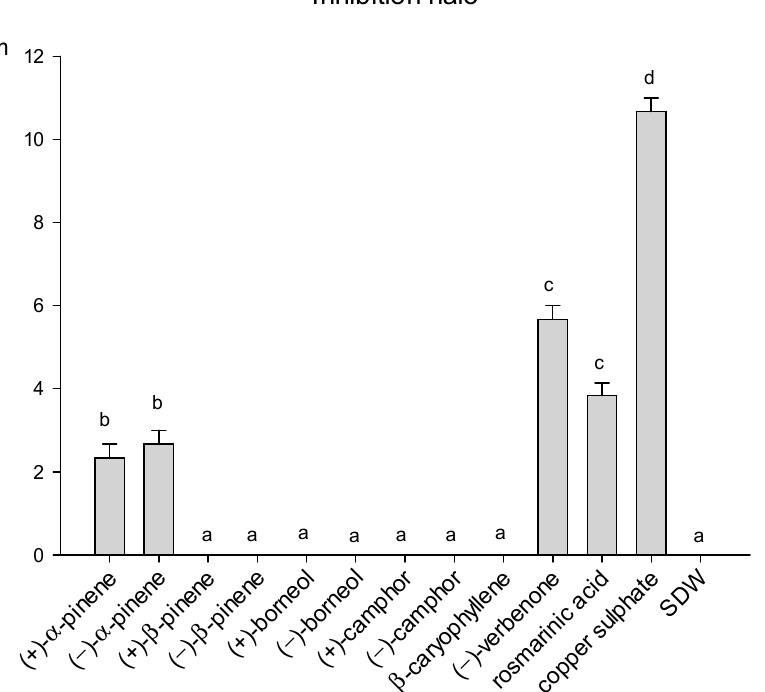
Figure 5. Growth of A. alternata colony diameter (mm) in the presence of different compounds of rosemary leaves, after 14 days of incubation at 25 °C. Data are means of 6 replicates + SE (standard error). Different letters indicate significant differences (by the Mann–Whitney U-test, p < 0.05) among the tested compounds.